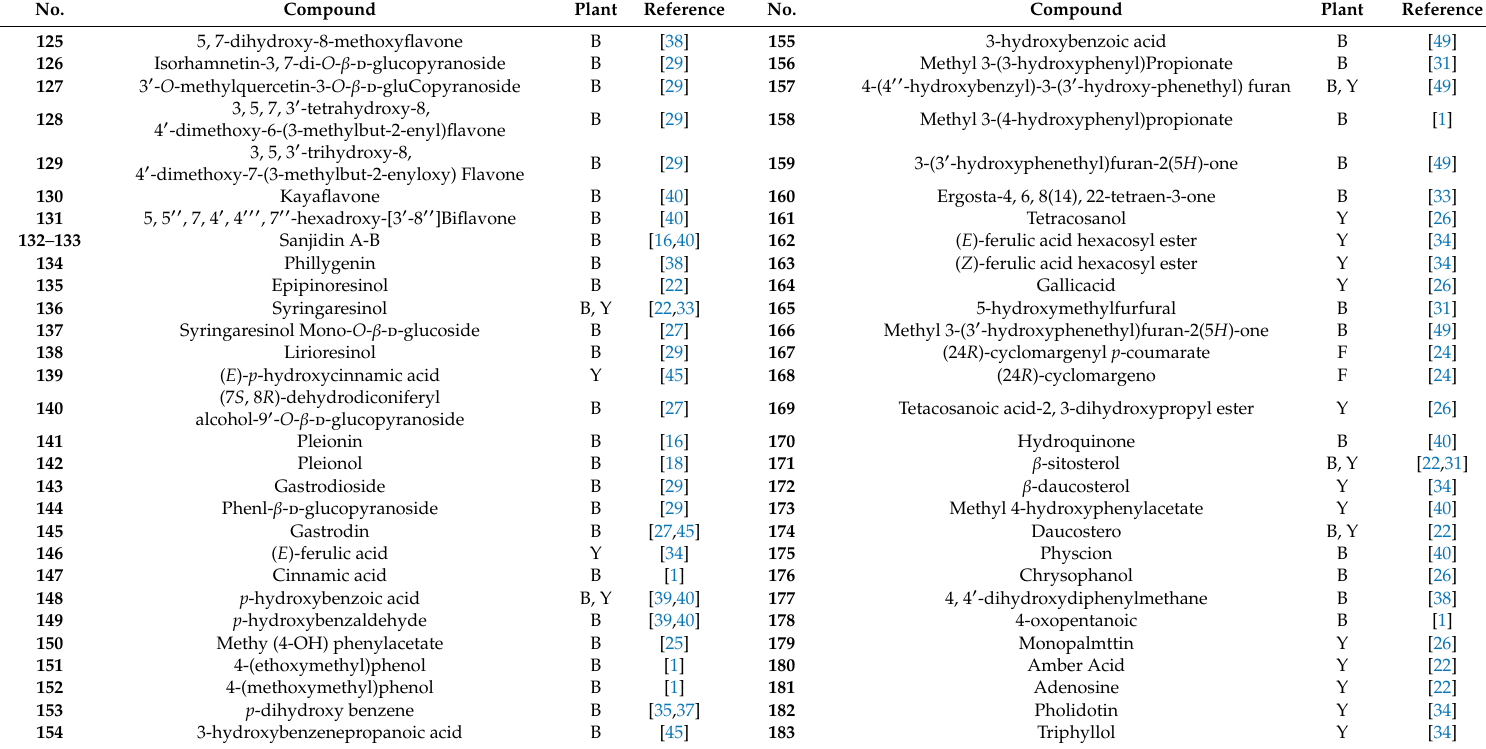
Table 8. Other compounds from Pleione